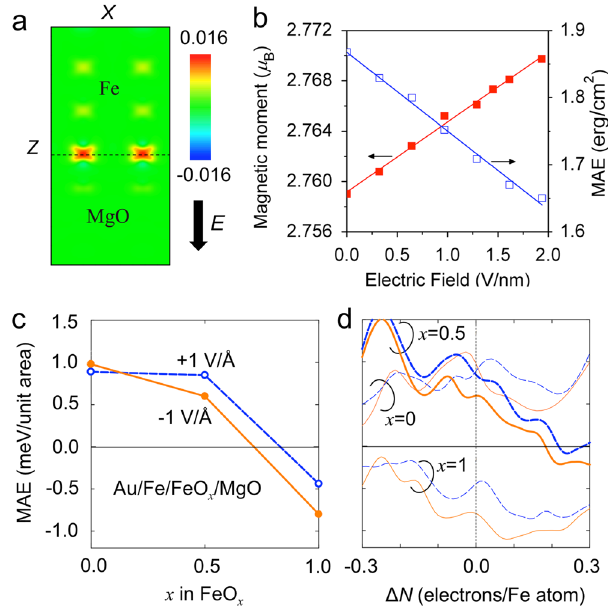
Fig. 3 a xz -plane distribution of electrically induced spin densities (in the unit of e /Å 3 ) across a Fe/MgO interface under an electric fi eld of 1 V/nm in the MgO. b Modulating the magnetic moment of the Fe atom at the Fe/MgO interface and the MAE of the Fe/MgO interface with an electric fi eld. In fl uence of c , degree of interfacial oxidation ( x in FeO x ), and d doping, on the electric fi eld modulation of MAE. Note that varying valence electrons Δ N is equivalent to modulating x in Fe 1 − x Co x . a , b were adapted with permission. 65 c , d were adapted with permission.